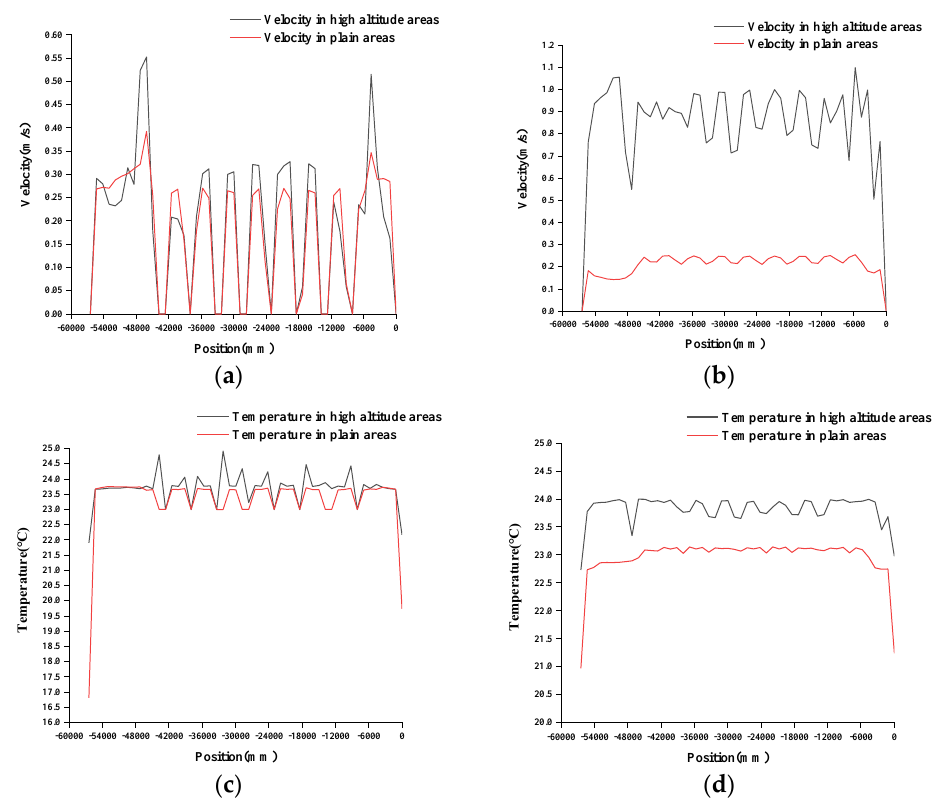
Figure 16. Variation in coupled ventilation parameters in high − altitude and plain areas of: ( a ) x = 4000 mm, velocity; ( b ) x = 600 mm, velocity; ( c ) x = 4000 mm, temperature; ( d ) x = 600 mm, temperature.